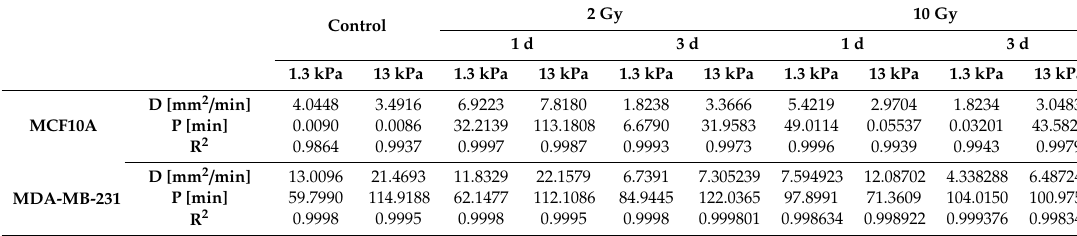
Table 3. Parameters describing the motility of